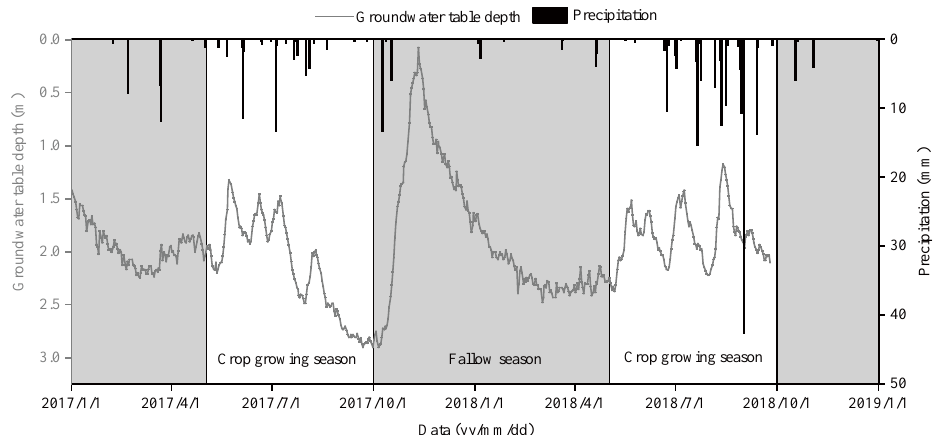
Figure 2. Precipitation and groundwater table depth in the study area during 2017 and 2018.